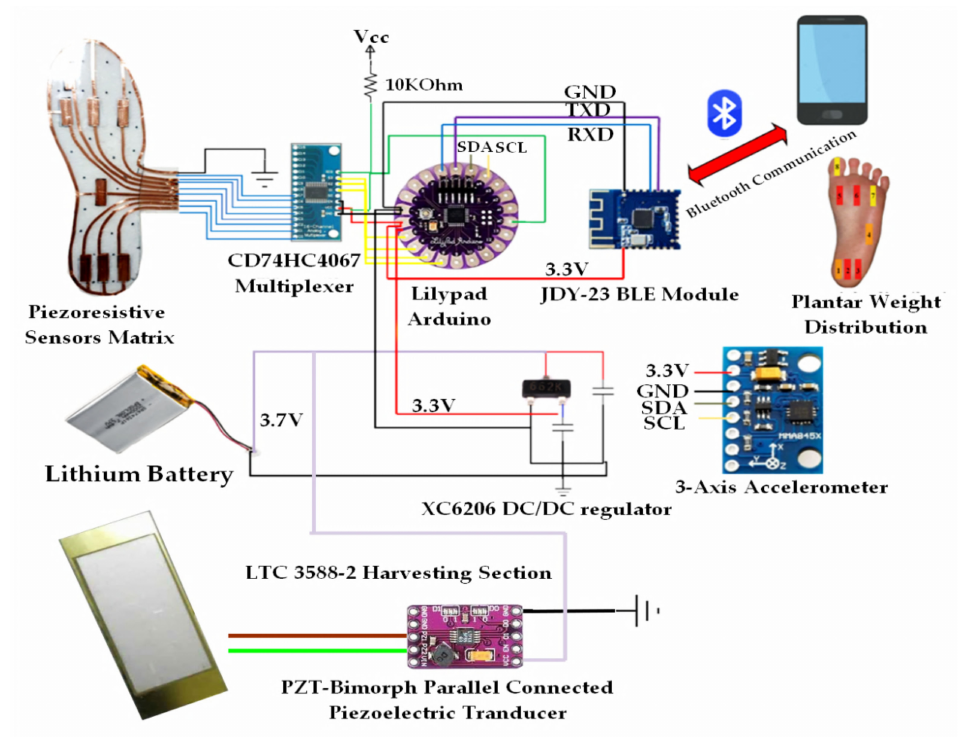
Figure 21. Graphical representation of the architecture of the developed smart